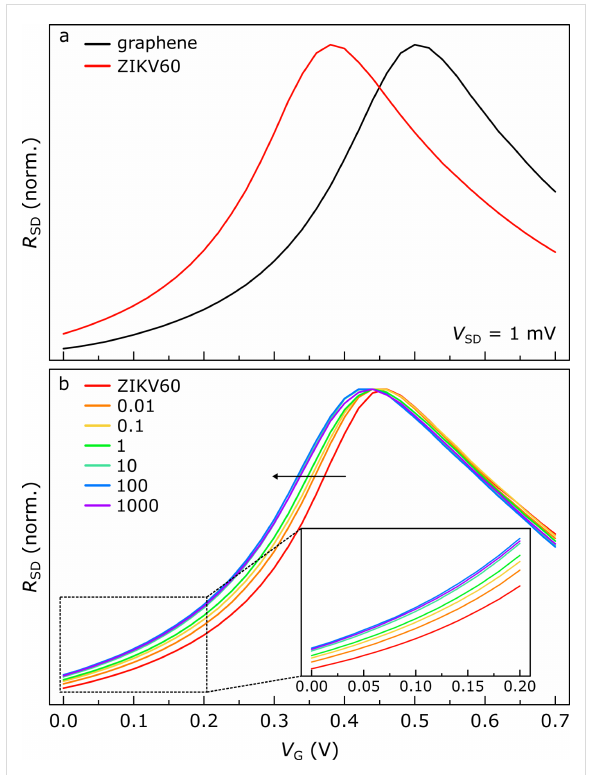
Figure 4: Functionalization of graphene with ZIKV60 and detection of ZIKV NS1 protein. (a) Representative curves of the normalized graphene resistance ( R SD ) as a function of the gate voltage ( V G ) before (black line) and after (red line) functionalization with ZIKV60 aptamers. These measurements were carried out using 100 mM PBS as electrolyte for gating. (b) Normalized graphene transfer curves of a single device functionalized with ZIKV60 aptamers before (red line) and after sequential addition of ZIKV NS1 protein with the following concentrations: 0.01 (orange line), 0.1 (yellow line), 1 (green line), 10 (cyan line), 100 (blue line), and 1000 (purple line) pg/mL. The inset highlights the portion of each graphene transfer curve extending from 0.00 to 0.20 V. In each measurement, ZIKV NS1 protein was diluted in human serum, which was used as electrolyte for